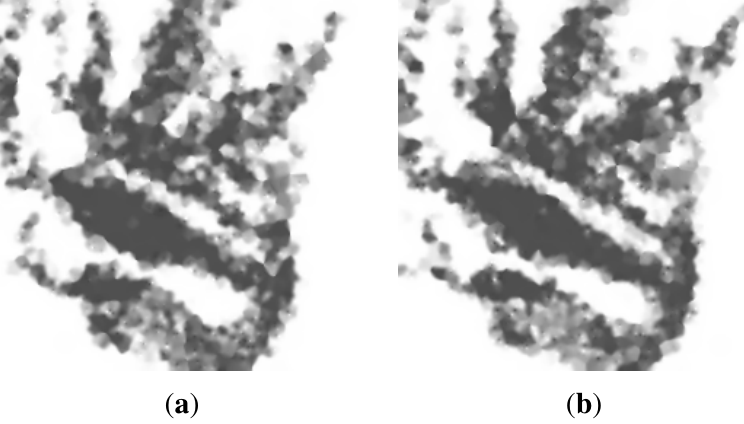
Figure 10. Maps generated from 2000 nodes randomly distributed on the surface from Figure 8 using the centralised and distributed mapping services